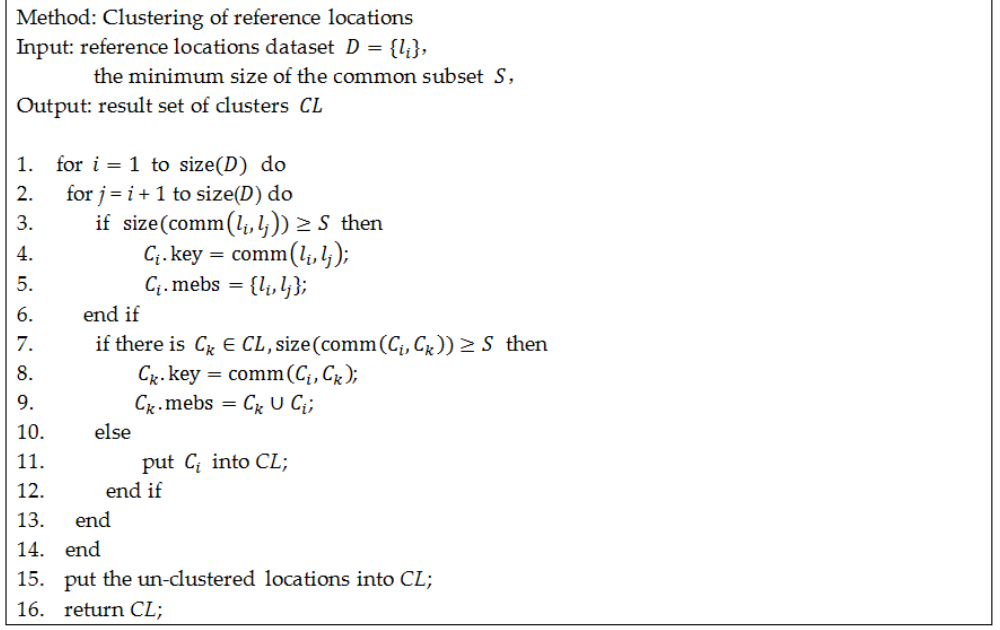
Figure 2. Pseudo-code of the proposed clustering method.